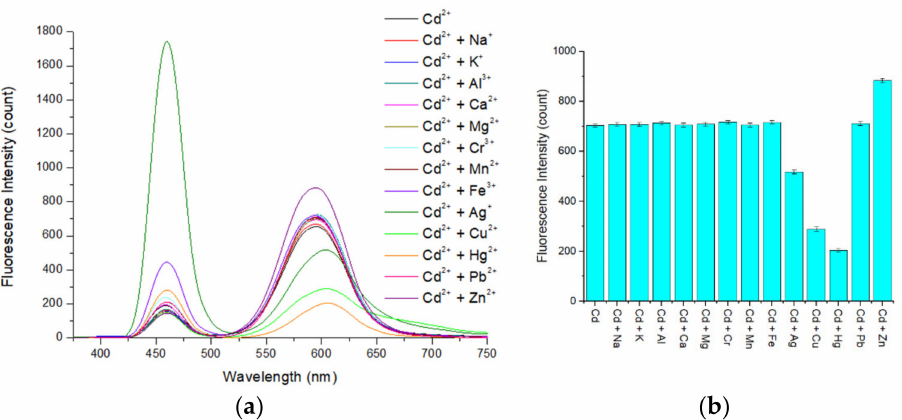
Figure 11. ( a , b ) Relationship between the fluorescence intensity of the restored QD solution and the presence of added Cd 2 + and other ions in the QD solution. Concentration of Tris-HCl bu ff er solution: 10 mmol / L. pH of Tris-HCl bu ff er solution: 8.5. Concentration of added QD solution: 5 µ mol / L. Concentration of APDC solution: 100 µ mol / L. Concentration of cadmium standard solution: 2.5 mmol / L. Concentration of other standard solutions: 2.5 mmol / L. Addition order: Tris-HCl bu ff er solution (2 mL) → QD solution (0.4 mL) → APDC solution (0.52 mL) → cadmium standard solution (0.008 mL) → other standard solution (0.008 mL) → Tris-HCl bu ff er solution (1.064 mL). Excitation wavelength: 460 nm. Observation time: 3 min. All data in this figure is mean of five measurements.